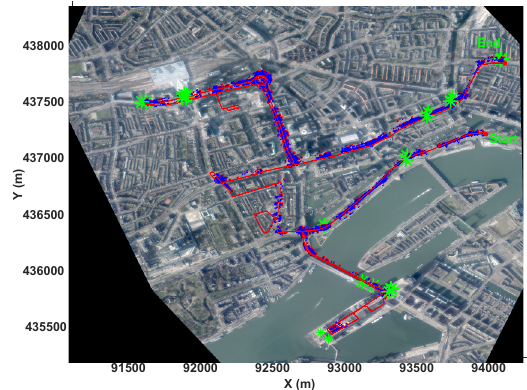
Figure 1: Kalman filtered trajectory (red curve), check points (as green asterisk) A2A tie points (blue dots) and A2P tie points (red dots). Note that there are mostly two check points at a single location.